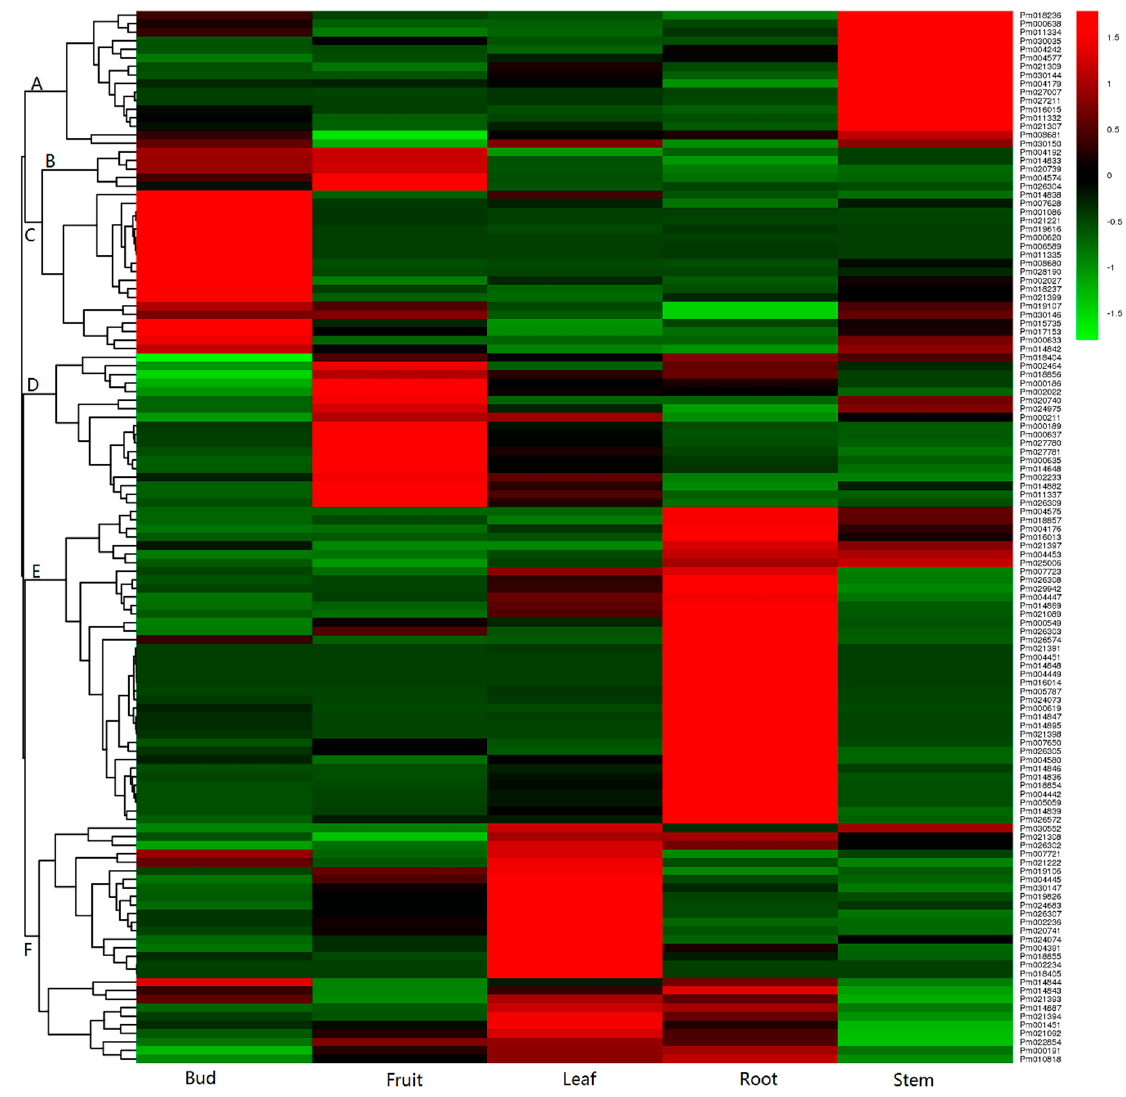
Figure 5. Expression profiles of PmUGTs in different tissues. The transcript abundances of PmUGTs in bud, fruit, leaf, root and stem were according to RNA-seq data. The scale represents signal intensity of FPKM values. Red indicates high relative gene expression and green indicates low relative gene expression. Letters assigned to major clusters are indicated on the dendrogram.